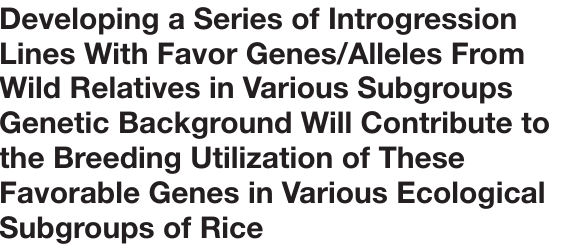
O. alta of rice (Yu et al., 2021). But, integration of new tools and interspecific hybridization can be mainstream to improve the Asian cultivated rice further in the